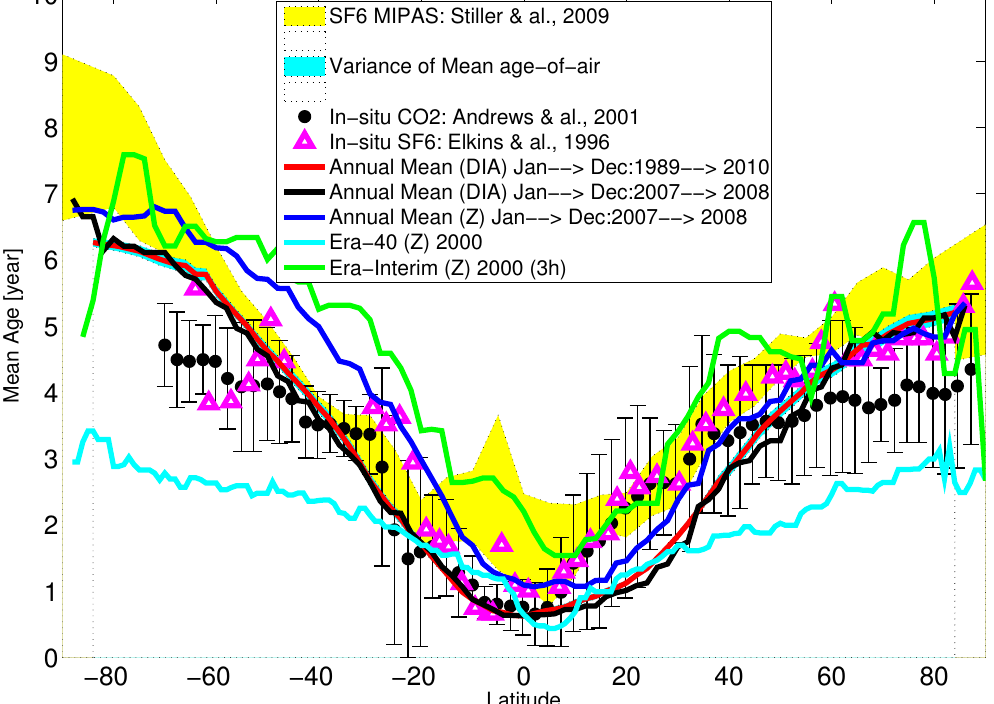
Fig. 5. Mean age of stratospheric air at 56hPa ( ∼ 20km) as a function of latitude, using ERA-Interim data unless specified. (Red): mean ages from diabatic trajectories averaged over 22yr (1989–2010). (Blue): mean ages from kinematic trajectories averaged over 2yr (2007– 2008). (Black): mean ages from diabatic trajectories averaged over 2yr (2007–2008). (Green): mean ages from kinematic trajectories and a perpetual run based on the year 2000 only. (Cyan): mean ages from kinematic trajectories and a perpetual run based on the year 2000 only with ERA-40 winds. (Yellow shaded area): envelope of mean ages from SF 6 MIPAS observations during November 2002–February 2003 and November 2003–February 2004 from Stiller et al. (2008). (Triangles): mean ages from airborne observations of SF 6 (Elkins et al., 1996; Waugh and Hall, 2002). (Dots and error bars): compilation of mean ages from airborne observations of CO 2 until 1998 by Andrews et al. (2001a). The error bar shows the statistical uncertainty of the mean age. The statistical uncertainty of the mean diabatic age is shown as ± one standard deviation (cyan shaded area) but this uncertainty is small enough to be hidden by the thickness of the red